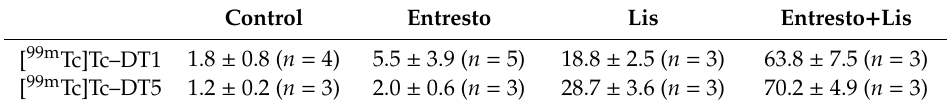
Data represents the mean percentage of intact radioligand ± SD; n of experiments are shown in parentheses.